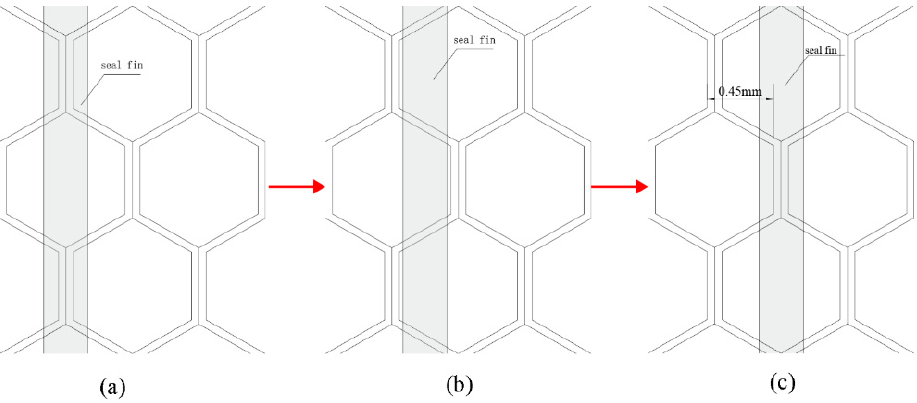
Figure 6. ( a – c ) The rub position between the seal fin and the honeycomb during axial rub.